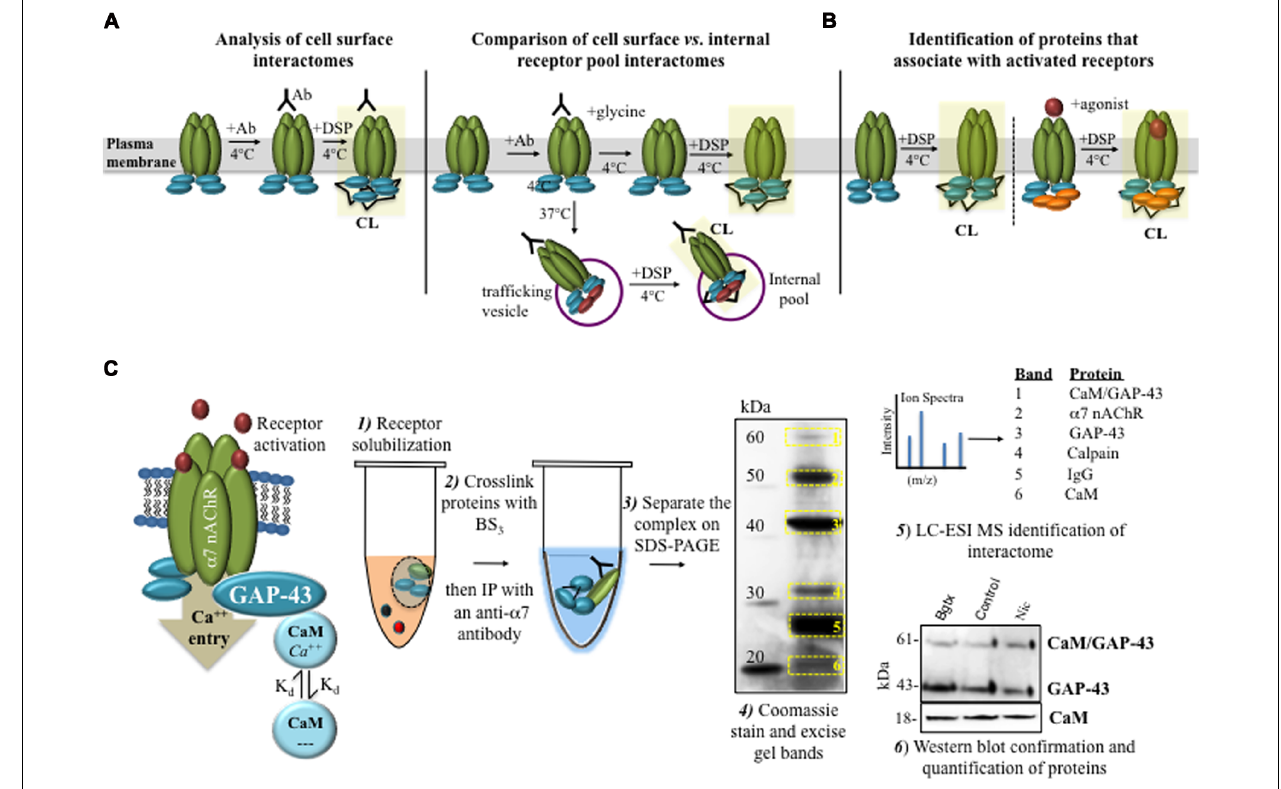
interactions under various ligand treatment conditions. (C) Experimental evidence on α 7 nAChR interactions with GAP-43 and CaM in developing neural cells. BS 3 was used to crosslink the α 7 nAChR interactome from differentiating cells. An IP was utilized to purify the receptor, which was visualized by SDS-PAGE. Protein identity was confirmed using LC-ESI MS and Western blot. These experiments demonstrate dynamic changes in CaM/GAP-43 association with α 7 nAChR in response to nicotine activation (Nordman and Kabbani,